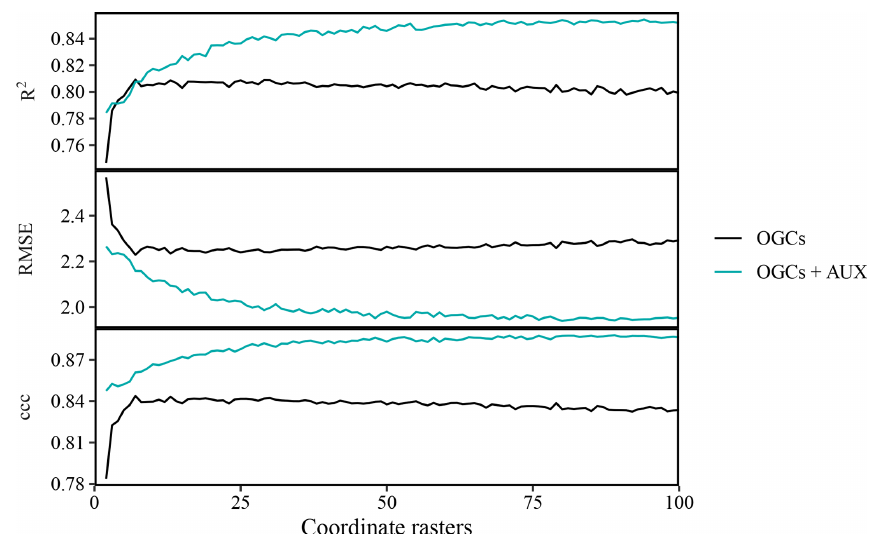
Figure 4. Effects of the number of coordinate rasters on the accuracy of SOM predictions on the Vindum dataset, calculated as Pearson’s R 2 , root mean square error (RMSE) and Lin’s concordance criterion (ccc). We calculated effects for random forest models trained on only coordinate rasters (OGCs) and with coordinate rasters in combination with auxiliary data (OGCs + AUX). The lines represent mean values obtained from 100 repeated splits (75% training dataset; 25% test dataset) for each number of coordinate rasters.